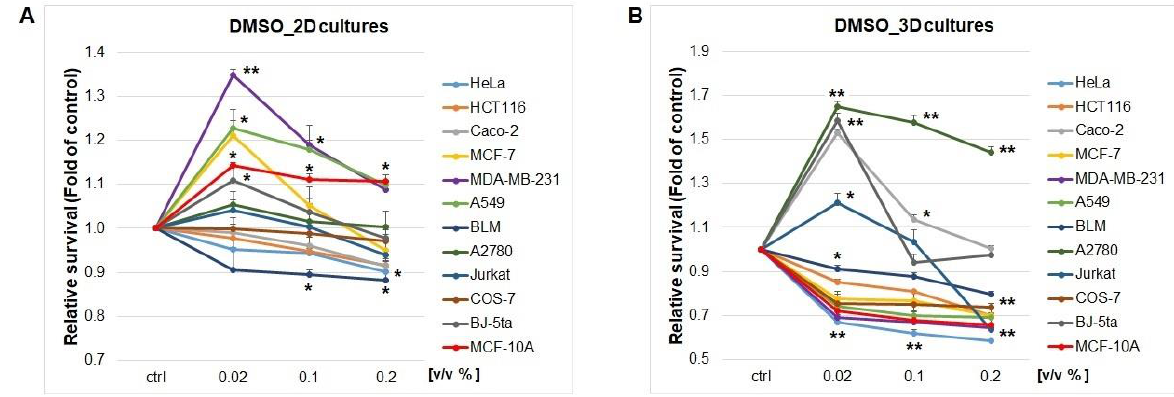
Figure 1. Metabolic activity influence (72 h) by DMSO vehicle in 2D ( A ) and 3D spheroid ( B ) cultures of various cancer and non-cancerous cell lines. Significance: * p < 0.05, ** p < 0.01 vs. untreated cells. In 3D spheroid models (Table 3), the best inhibition effects were shown by the same extracts as in the 2D model, Lobaria pulmonaria (8.3–150.8 µ g/mL), Evernia prunastri (46.7–551.2 µ g/mL), Stereocaulon tomentosum (44.5–552.0 µ g/mL) and Pseudevernia furfuracea (19.5–129.0 µ g/mL), with the addition of Umbilicaria hirsuta extract (9.3–143.3 µ g/mL) and secondary metabolite gyrophoric (17.9 – 148.6 µM) acid. Physodic acid in the 3D spheroid model showed significantly higher IC 50 values compared to 2D. We cannot generally con- clude from 3D spheroids ’ results that three-dimensional cultivation and altered physiol- ogy of spheroids led to lower susceptibility to tested extracts and less effectiveness, with higher IC 50 values. The best example from our results is the ovarian cancer cell line A2780 where in all cases 3D IC 50 values increased several times compared to the 2D model. Fur- thermore, cisplatin IC 50 (6.7 – 183.8 µM) was most raised compared to 2D model. From the view of cancer cell line tissue origin and the number of extracts/metabolites with 3D IC 50 under 100 µg/mL or 100 µM, the most sensitive cell lines were MDA-MB-231 (seven sub- stances) ˃ MCF-7 = HeLa (6) ˃ HCT116 = A549 (5) ˃ Jurkat (3) ˃ Caco-2 = BLM (2) ˃ A2780 (1). Paradoxically, the DMSO vehicle 3D test (Figure 1B) showed significant metabolic in- hibition from lower doses of 0.02% v / v . Compared to the 2D model, the hypothetical val- ues mimicking extract or secondary metabolite concentrations when the solvent reached 50% cytotoxicity are also lower. We suggest that spheroids ’ physiology strongly influ- ences the cytotoxicity of solvent or lichen extracts/metabolites diluted in it. The main dif- ferences between the 2D and 3D models is that after 4 days of spheroid formation based on 10,000 cells, a significant fraction of the cells inside the spheroids undergo hypoxia and can naturally suffer from nutrient/oxygen deficiencies. These cells therefore probably started to die naturally, which was manifested in the fact that the 3D model compared to the 2D model showed increased cytotoxicity after DMSO or lichen extract/metabolites treatment. Increased sensitivity of cells to solvent must be taken into consideration. Alter- natively, less toxic or non-toxic solvent must be used in preparation if possible. Table 3. IC 50 values (µg/mL or µM) list from 3D spheroids screening analyses. 3D